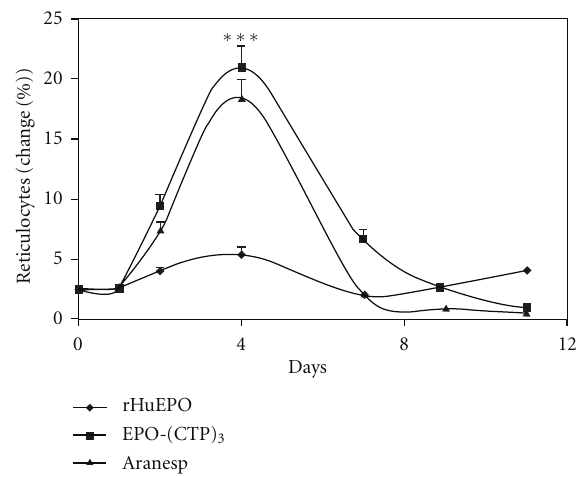
Figure 6: The e ff ect of a single IV injection of EPO variants on reticulocyte counts in mice. ICR mice ( n = 7/group) received a single IV injection/week for three weeks of rHuEPO, Aranesp, or EPO-(CTP) 3 (15mg/kg). Blood samples were collected after 72 h and reticulocytes were counted. Each point represents the group average of reticulocyte (%) ± SE. ∗∗∗ P < 0 .